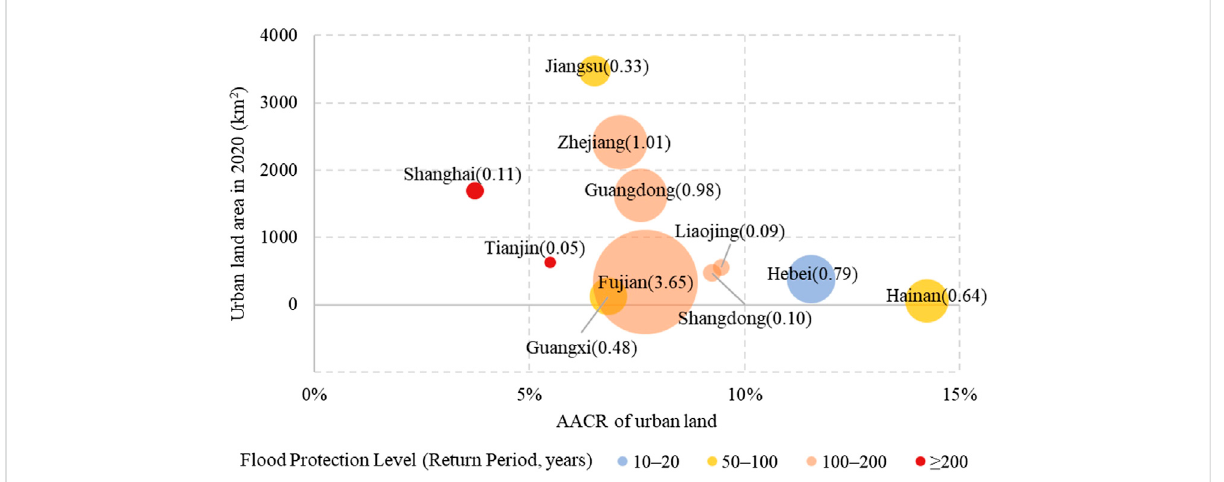
FIGURE 7 The province-level relationship between storm surge losses, urban lands in CFAs in 2020, and its average annual change rates (AACR) during 2000 – 2020. Note: the circle size represents the rate of storm surge losses to the GDP, which are shown in brackets ( ‰